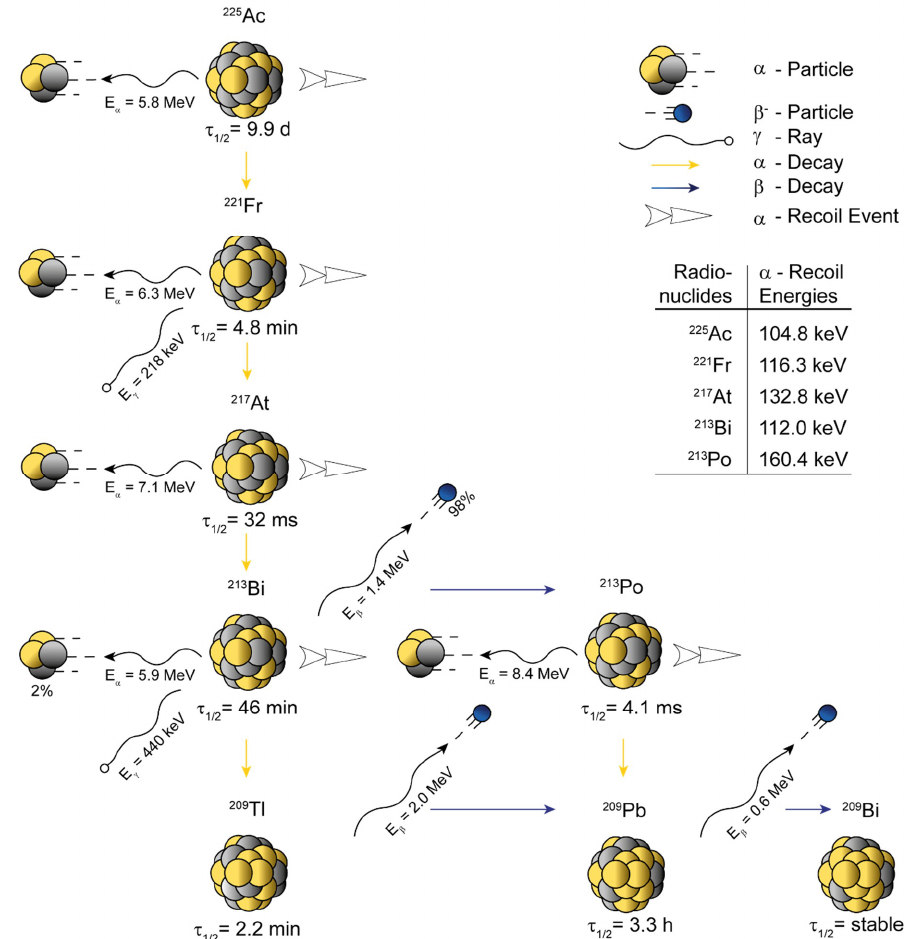
Figure 1. Schematic representation of the atomic in vivo nanogenerator 225 Ac (τ ½ = 9.9 d, E α = 5.8 MeV). 225 Ac decays through four net α-disintegrations (five in total) and two net β – -disintegrations (three in total) into stable 209 Bi. The 225 Ac decay chain possess two eligible γ-emissions for detection, 218 keV (I = 11.4%, 221 Fr) and 440 keV (I = 25.9%, 213 Bi). The most prominent daughter radionuclide is 213 Bi (τ ½ = 45.6 min, E α = 5.9 MeV), which is also used for targeted alpha therapy (TAT) itself. The half-life (τ ½ ), known energies connected to recoil events (translational kinetic energy E t ), and the decay energies (E α , E β , E γ ) are indicated on the scheme. Data were derived from Nucleonica GmbH, Nuclide Datasheets, Nucleonica Nuclear Science Portal (www.nucleonica.com), Version 3.0.65, Karlsruhe (2017).